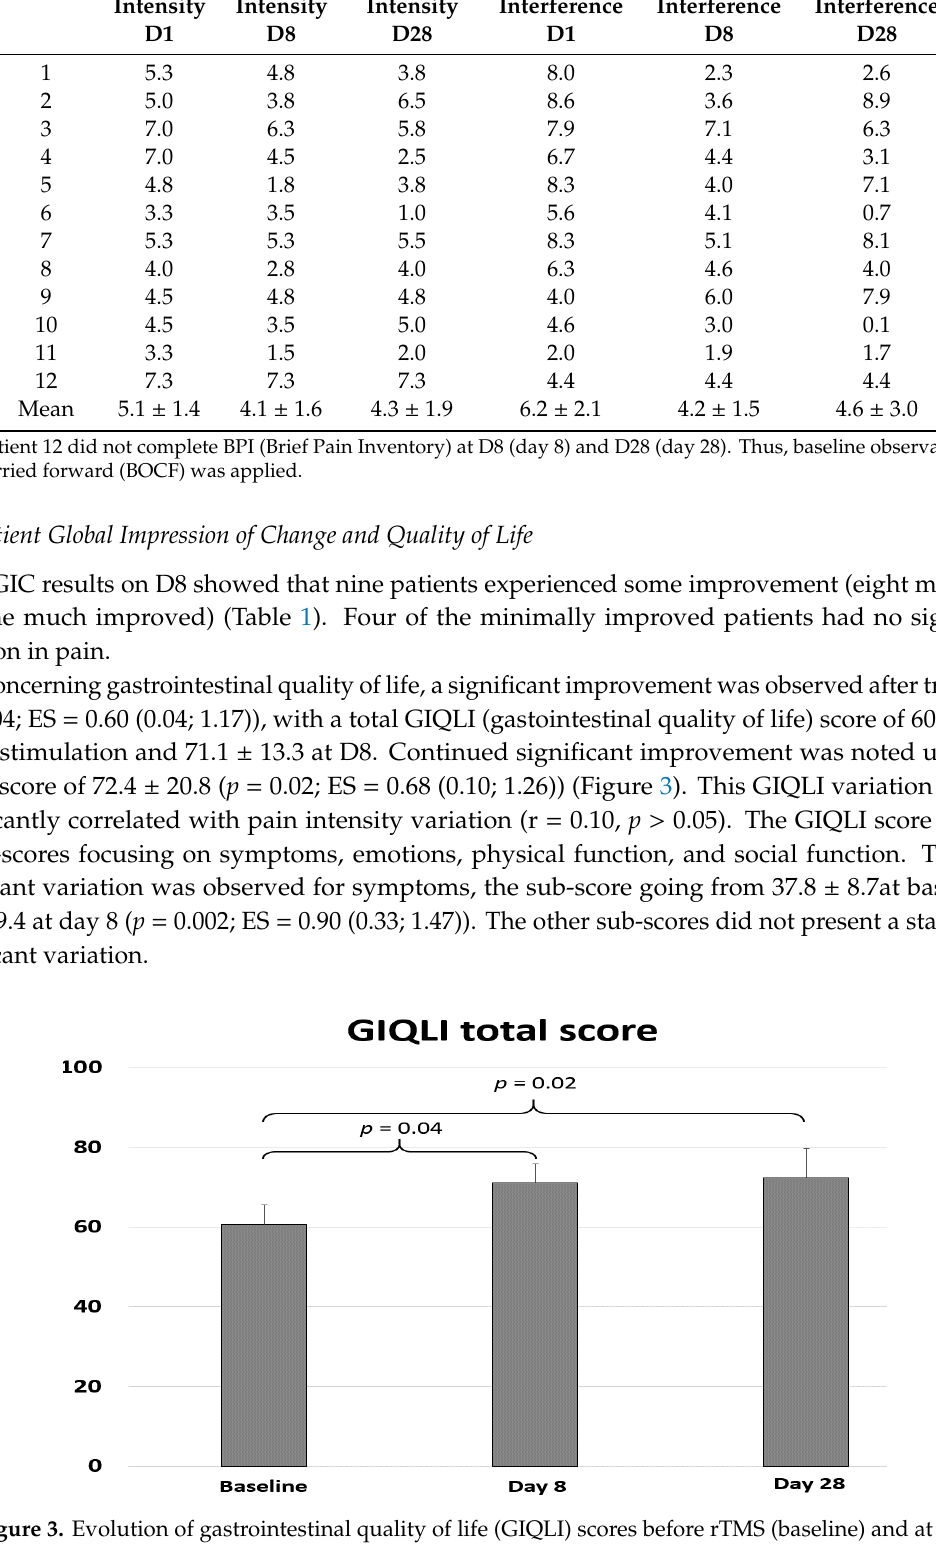
Figure 3. Evolution of gastrointestinal quality of life (GIQLI) scores before rTMS (baseline) and at day 8 and day 28; day 1 corresponding to the first rTMS session.